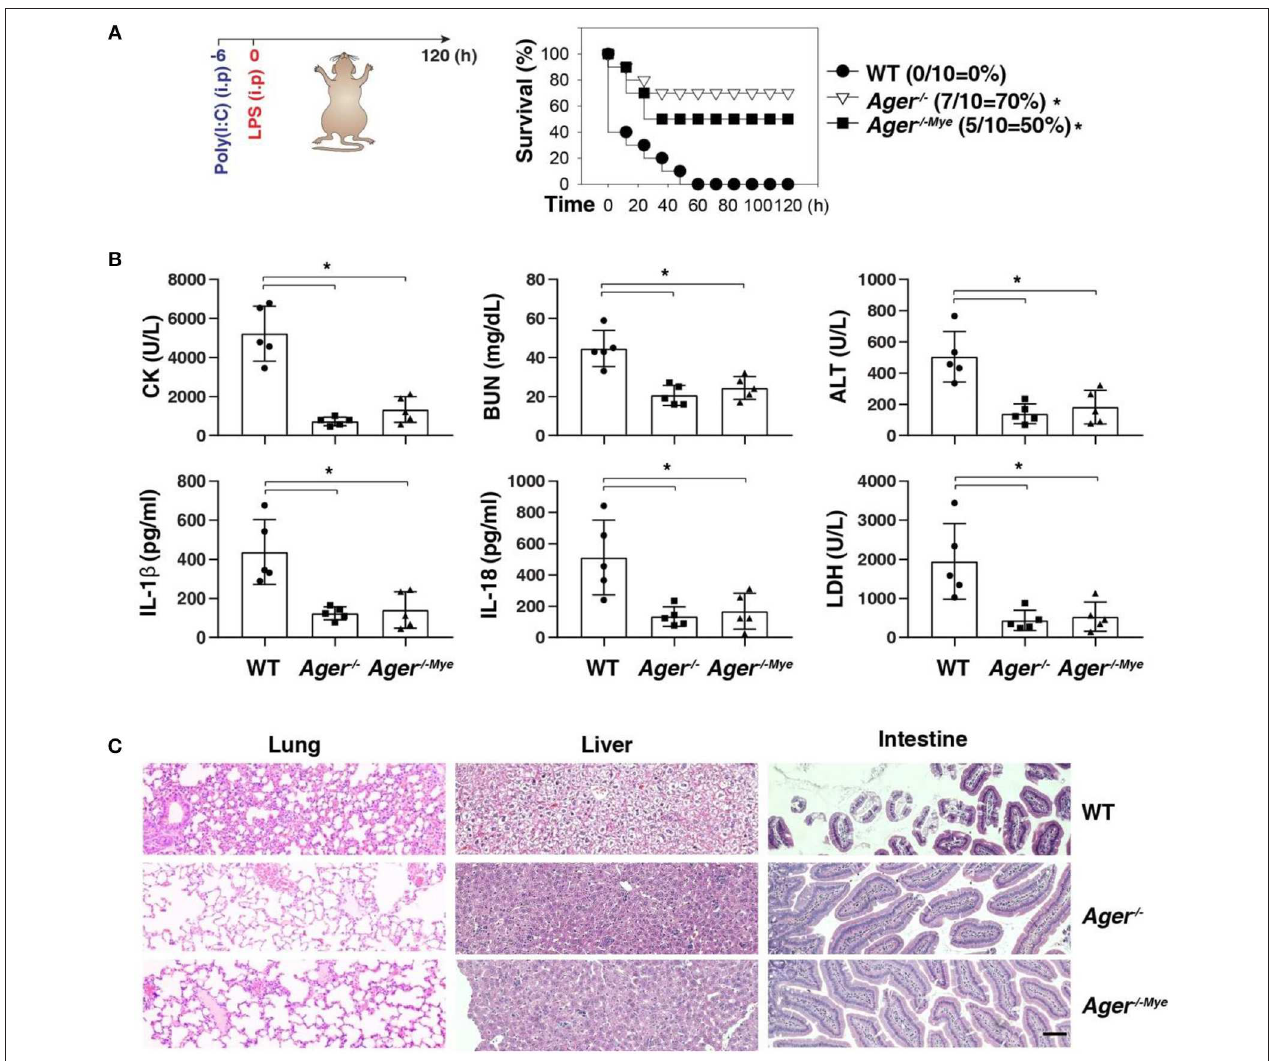
FIGURE 5 | Depletion of AGER protects against septic shock. (A) Survival of indicated mice primed with poly(I:C) (10 mg/kg, i.p.) and then challenged 6h later with LPS (2 mg/kg, i.p.). n = 10 mice/group, * P < 0.05, Kaplan-Meier survival analysis. (B,C) In parallel to panel A, quantitation of indicated serum markers (B) or hematoxylin/eosin staining of indicated tissues (C) in poly(I:C)-primed mice challenged with LPS at + 3h (bar = 100 µ M). n = 5 mice/group, * P < 0.05, ANOVA LSD test. Animal data represent two independent